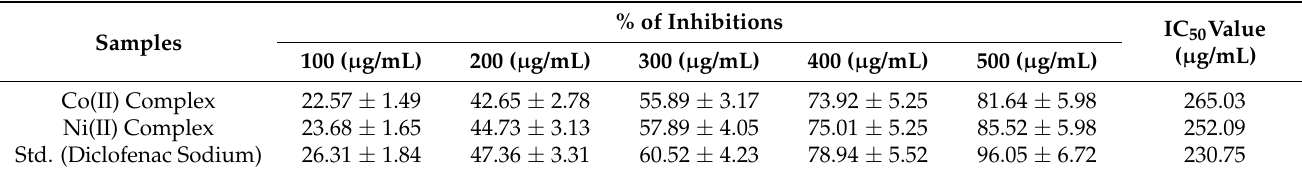
Table 3. In vitro anti-inflammatory (egg albumin) activity of our samples.